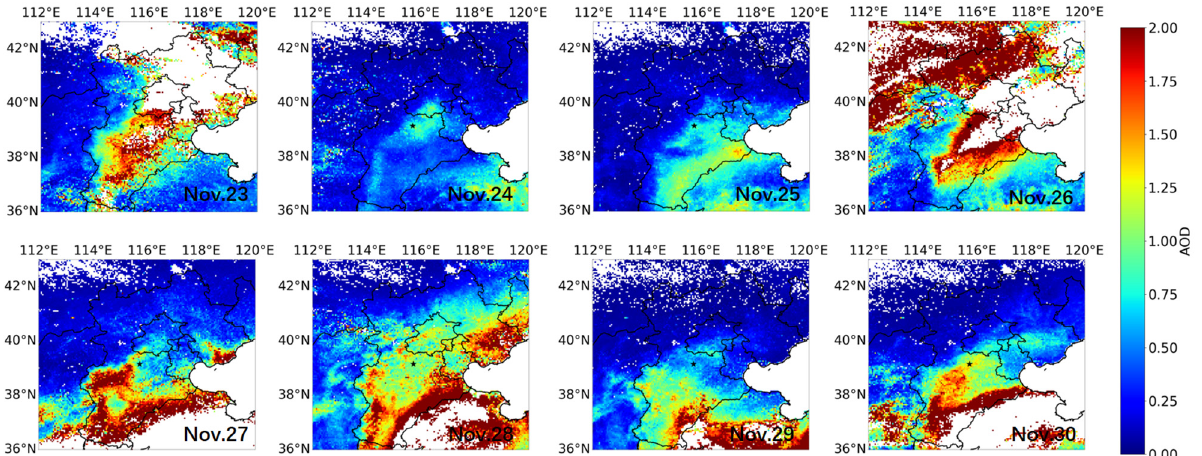
Figure 11. Daily average spatial distribution of Beijing–Tianjin–Hebei AHI AOD from 23 to 30 November 2018, with the location of Gucheng denoted by a black star.